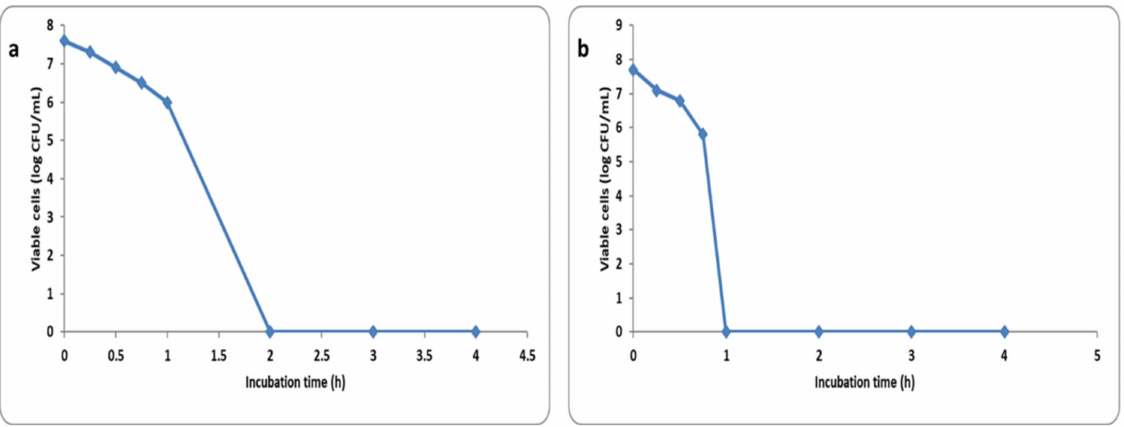
Figure 8. Time kill plot of ( a ) 4 × MIC and ( b ) 8 × MIC of the green synthesized AgNPs against S. aureus